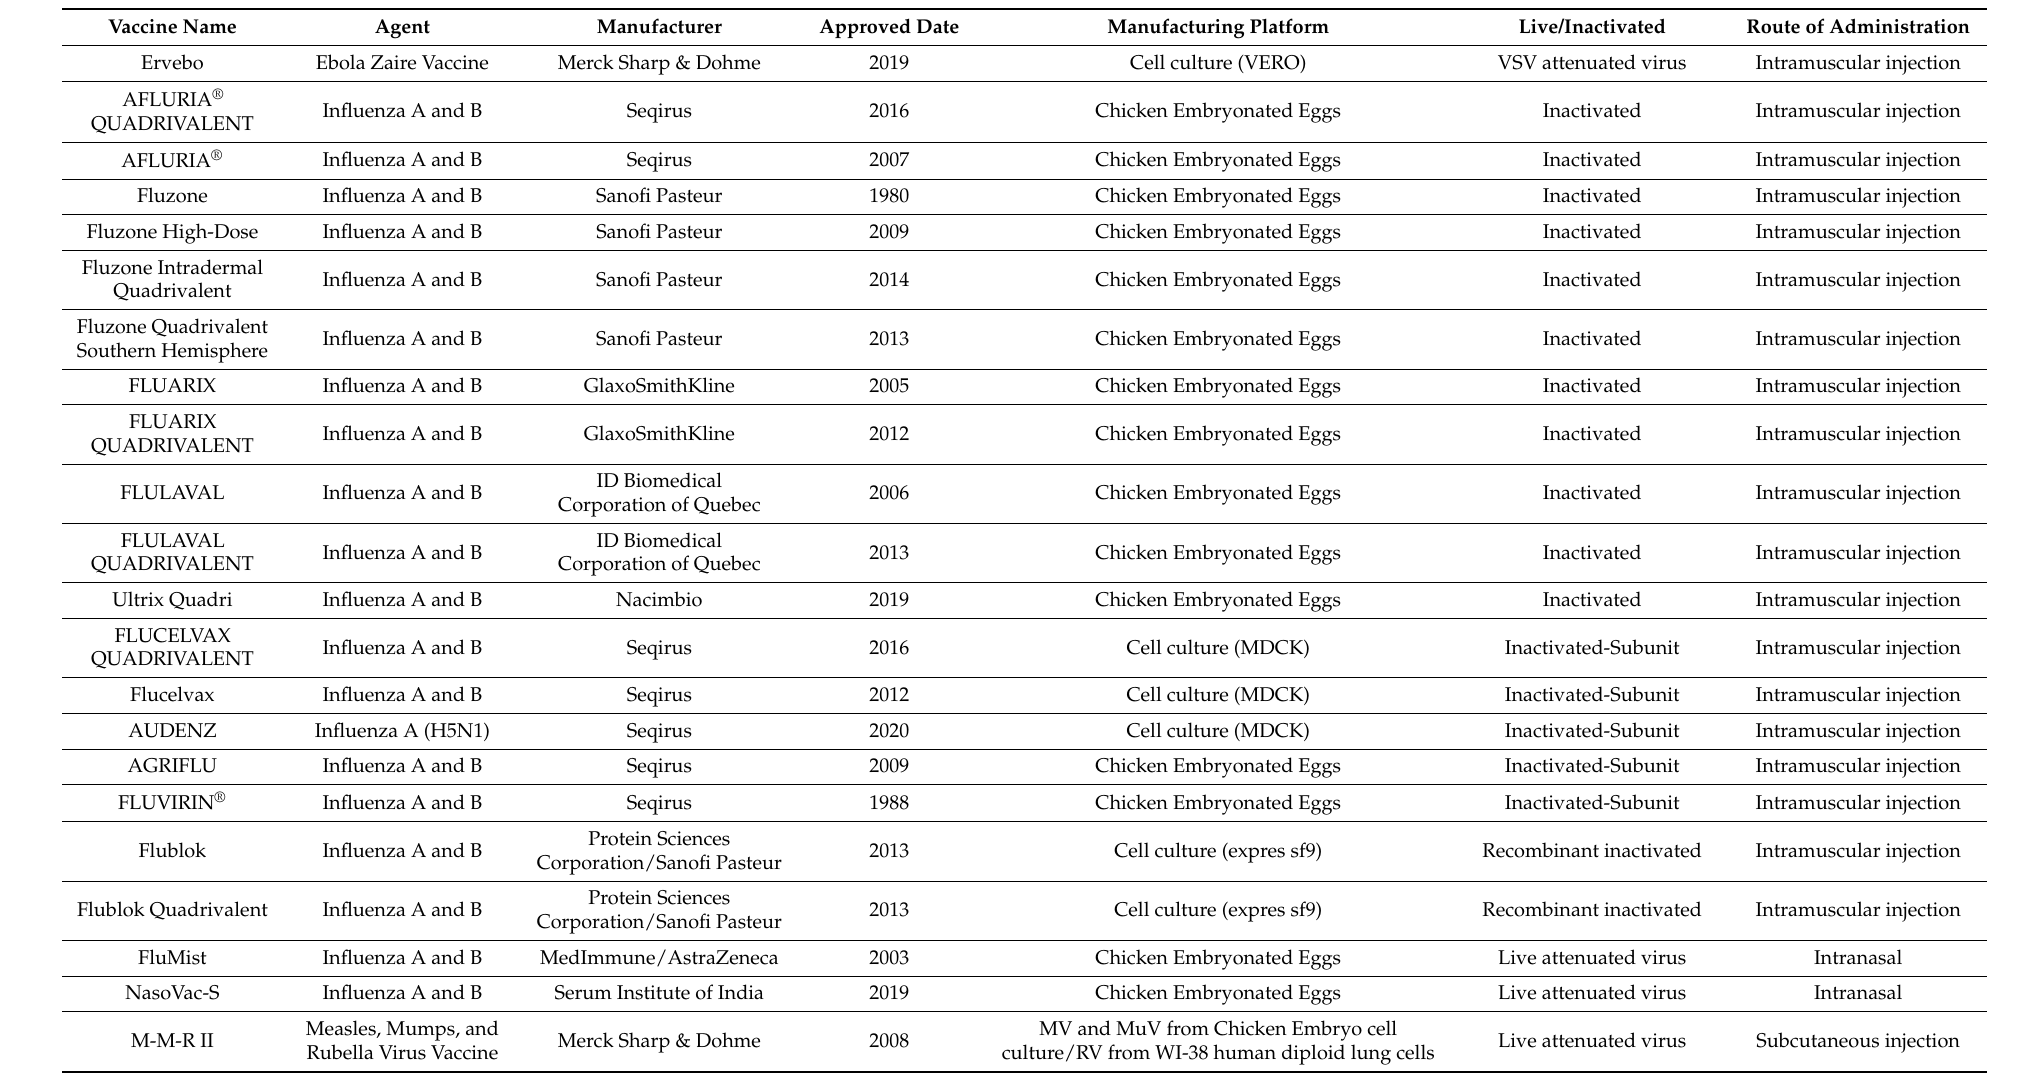
Table 1. List of NSV vaccines in the